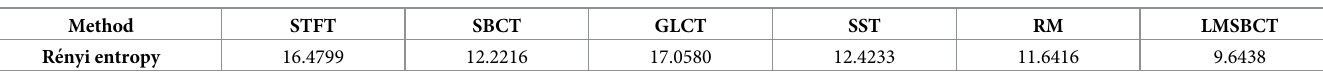
Table 1. Re´nyi entropy of different algorithms.